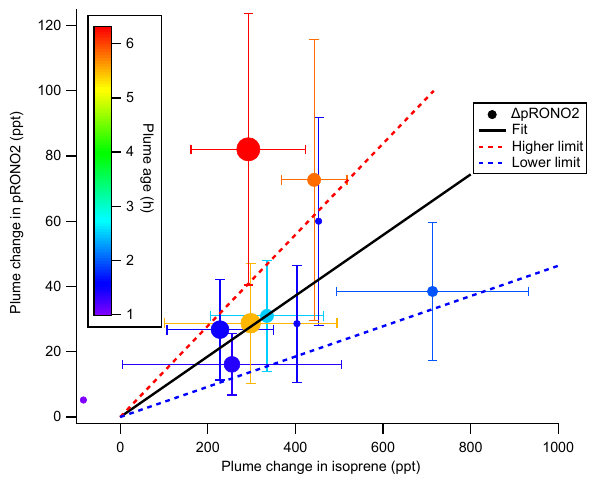
Figure 6. Correlation of organic aerosol mass concentration with pRONO 2 mass concentration for the full 2 July flight (grey points and red fit line, fitted slope and thus average OA / pRONO 2 mass ratio of ∼ 30) and for the points during the selected plumes (colored points, colored by plume age, average OA / pRONO 2 mass ratio of ∼